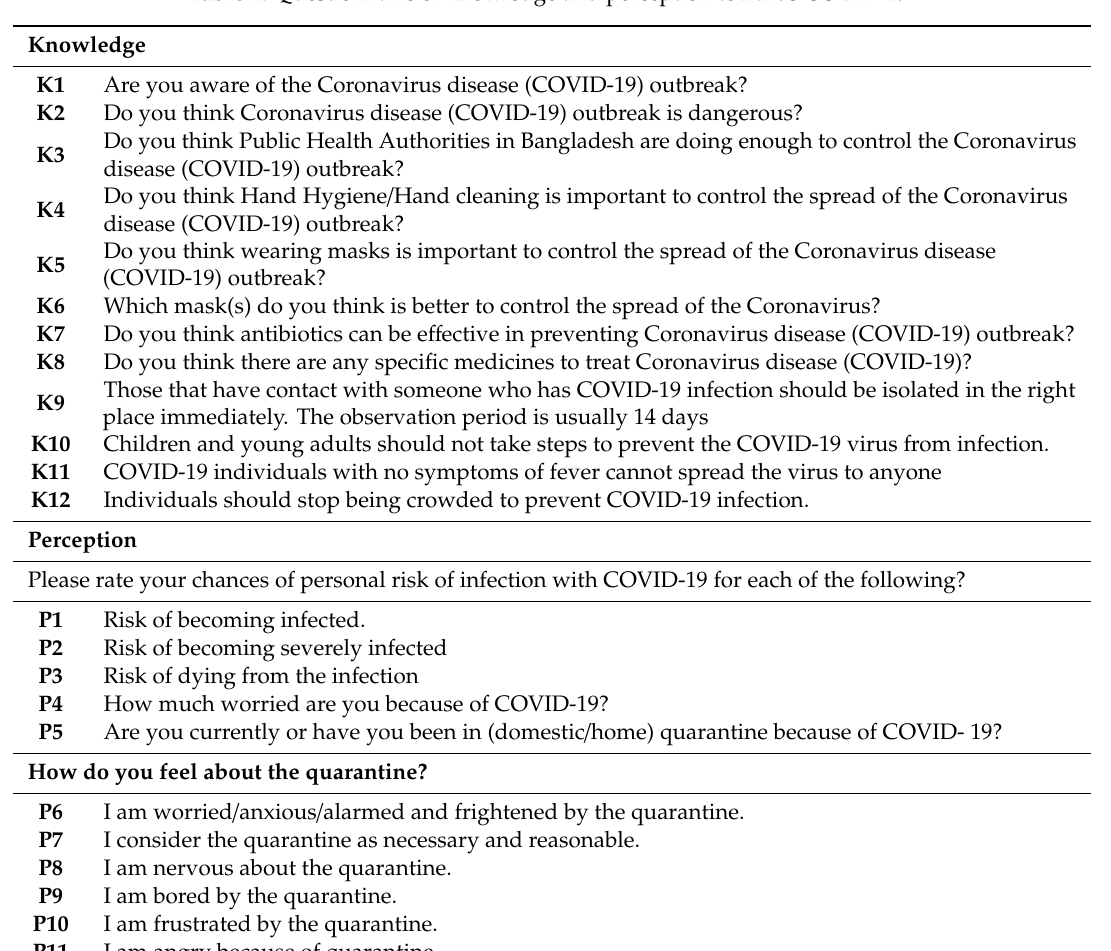
Table 1. Questionnaire of knowledge and perception towards